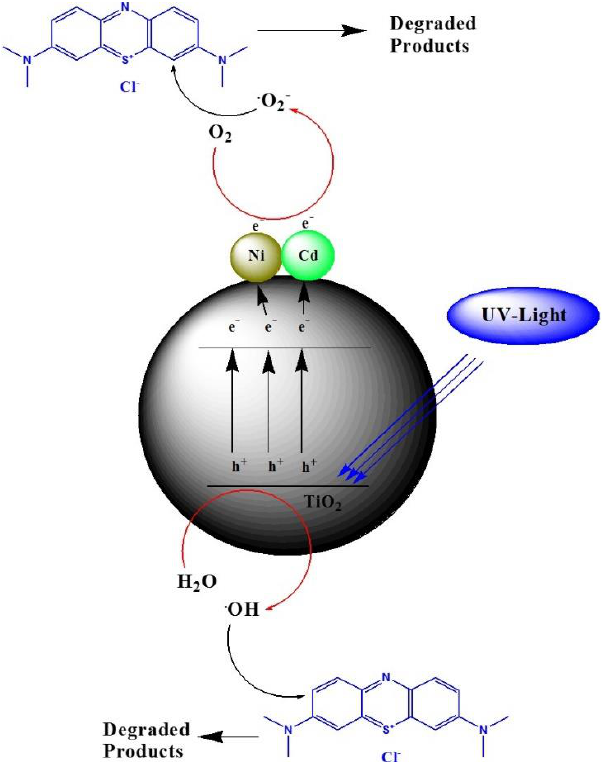
Figure 11. Proposed mechanism of photodegradation of MB dye by NiCdTiO 2.